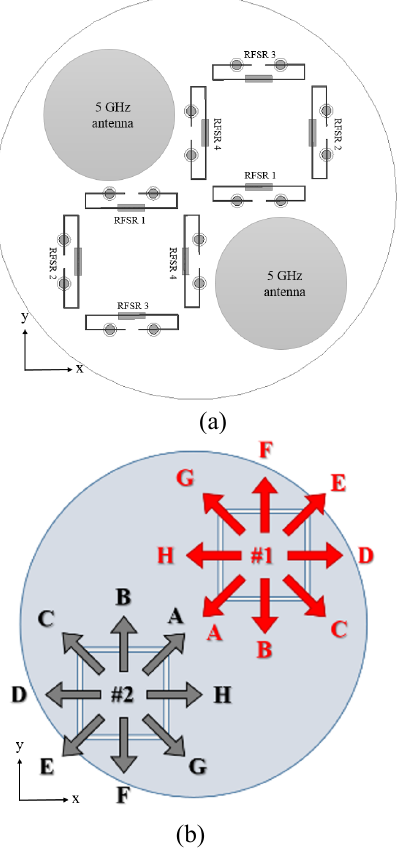
Figure 12: Proposed MIMO antenna: (a) layout of the proposed MIMO antenna and (b) beam directions of the MIMO antenna.